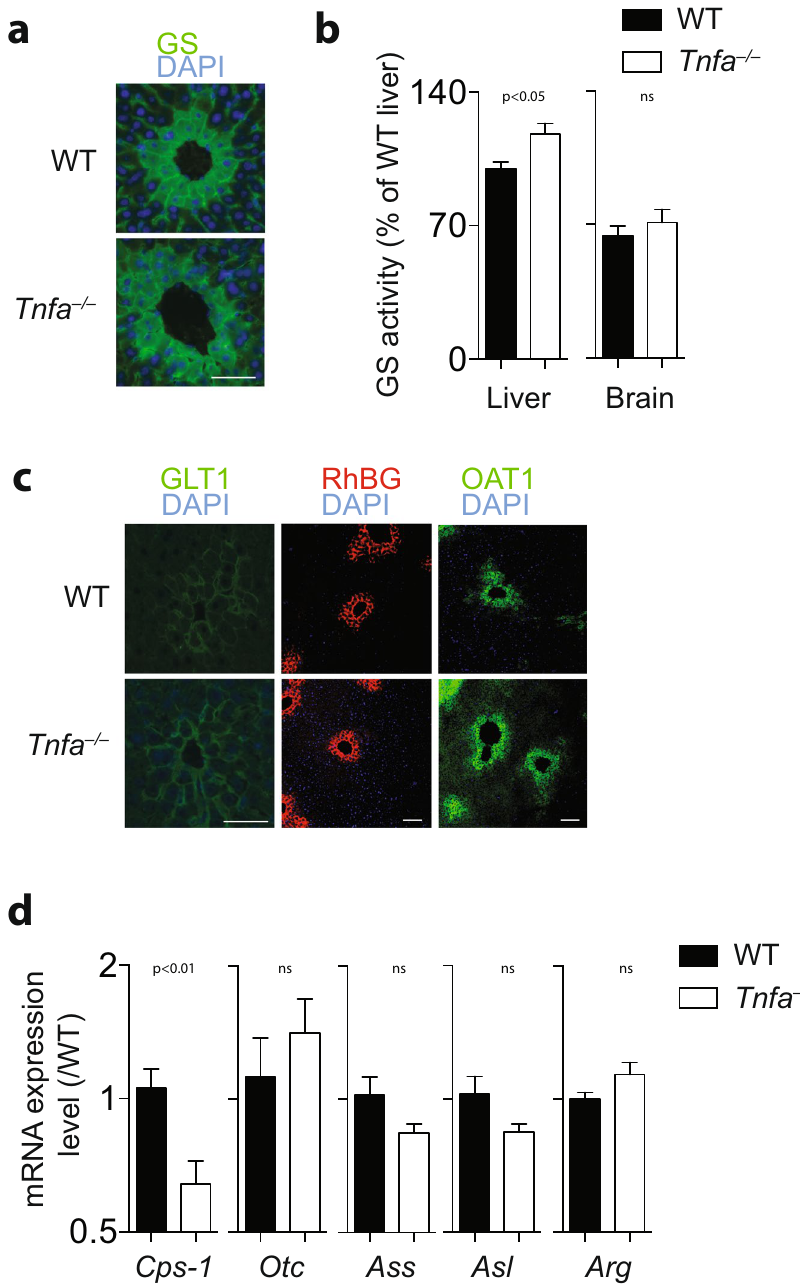
Figure 2. Intact liver structure but reduced hepatic expression of CPS-1 in TNF α deficient animals. (a) Sections from snap frozen liver tissue harvested from WT and Tnfa − / − mice were stained with anti-GS antibodies (One representative of n = 6 is shown, Scale bar = 25 µ m). (b) GS activity was measured in liver tissue (left panel, n = 6), and whole brain tissue (right panel, n = 3) from WT and Tnfa − / − mice. (c) Sections from snap frozen liver tissue from WT and Tnfa − / − mice were stained with anti-GLT1 (left panels, scale bar = 25 µ m), anti-RhBG (middle panels, scale bar = 100 µ m), and anti-OAT1 antibodies (right panels, scale bar = 100 µ m). One representative out of n = 6 is shown. (d) RNA expression levels of Cps-1 (n = 9), Otc (n = 6), Ass (n = 6), Asl (n = 6), and Arg (n = 6) were determined in liver tissue from WT and Tnfa − / −